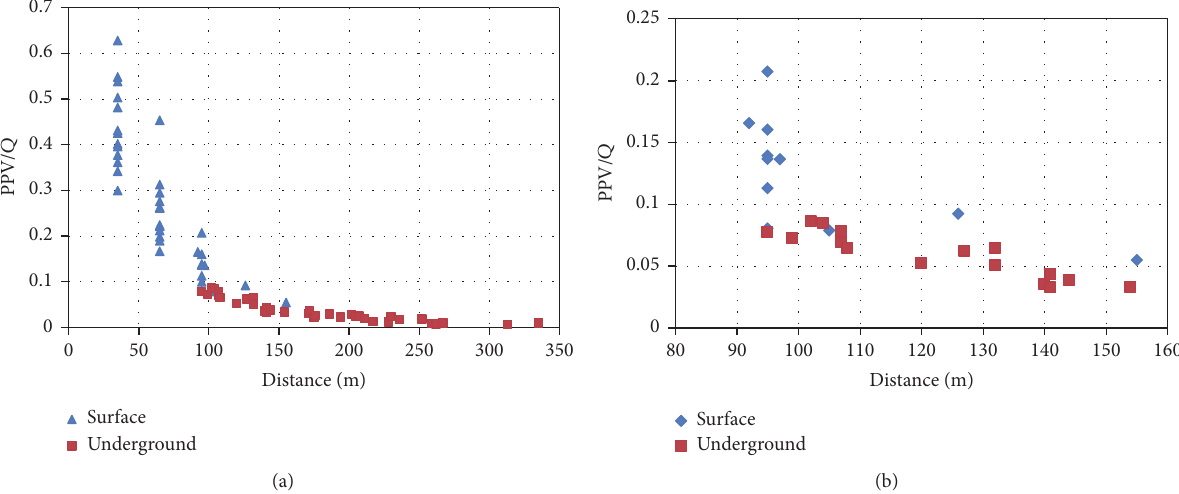
Figure 4: Representation of PPV per unit charge versus the distance on surface and underground. (a) Total figure. (b) Partial figure.